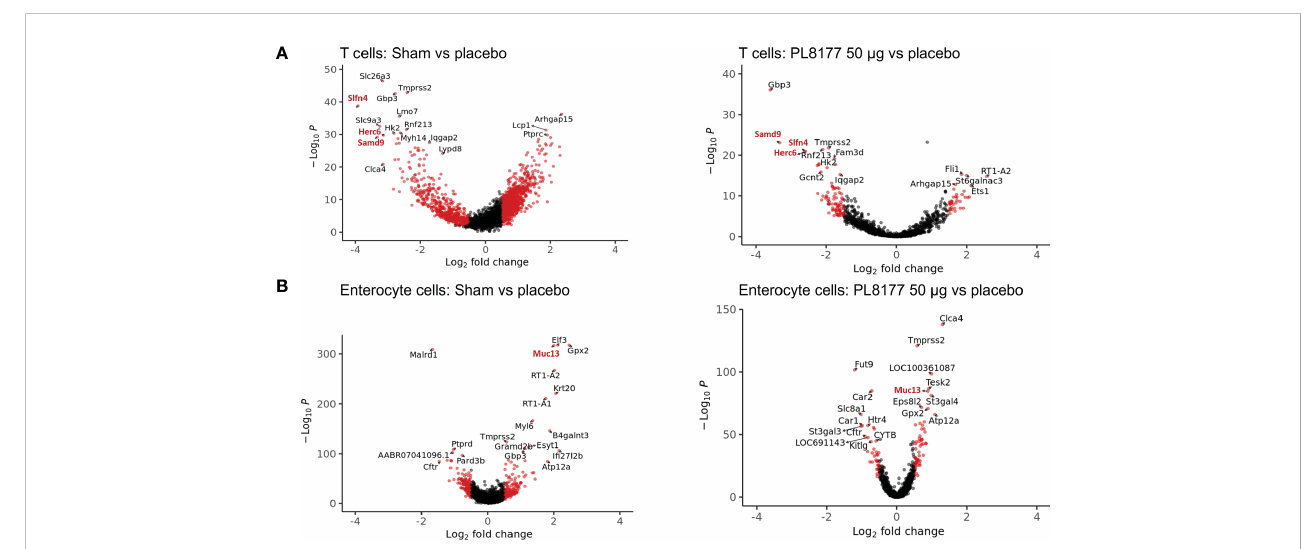
FIGURE 9 Genes differentially expressed in T cells and enterocyte cells of sham and PL8177 50 µg DSS colitis – induced rats as compared to placebo group. (A) Differentially expressed genes in T cells. Shown in red are genes with log 2 FC >1.5 and P <0.00001. Gene names in red are the top common differentially expressed genes in sham and PL8177 50 µg T cells. (B) Differentially expressed genes in enterocytes. Shown in red are genes with log 2 FC >0.5 and P <0.001. The gene name in red is the top common differentially expressed gene in sham and PL8177 50 µg enterocyte cells.